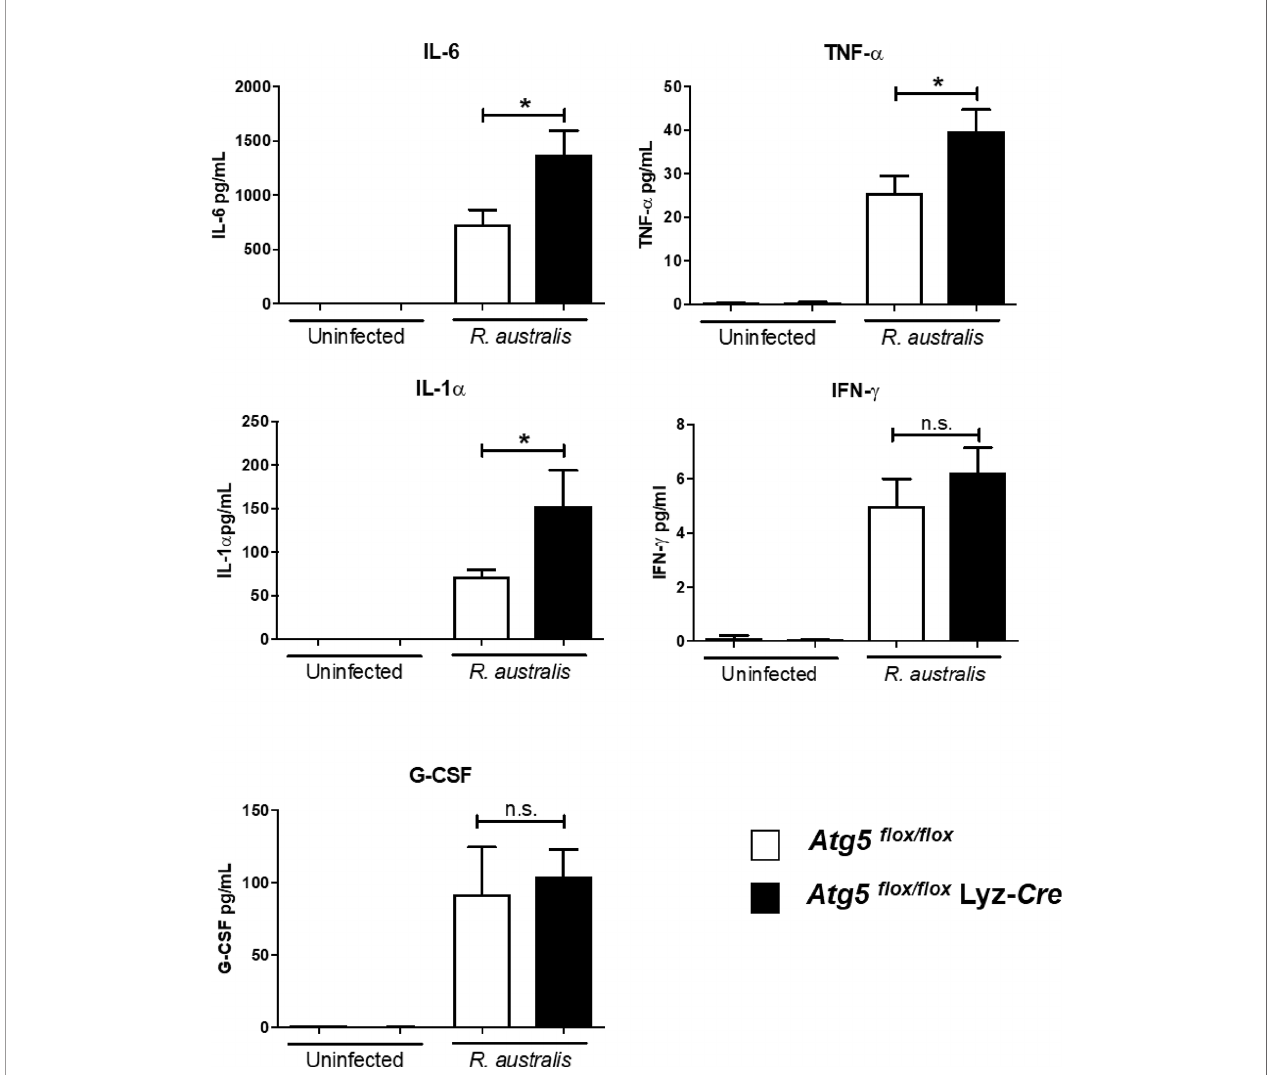
FIGURE 4 | (previous Figure 4). R. australis counteracts the production of pro-in fl ammatory cytokines by infected macrophages via Atg5 -dependent autophagy. BMMs were isolated from Atg5 fl ox/ fl ox Lyz- Cre and Atg5 fl ox/ fl ox mice, and they were infected with R. australis at an MOI of 5. At 24 h p.i., supernatant was harvested. Production levels of cytokines including IL-6, TNF- a , IL-1 a , IFN- g and G-CSF in the supernatant were assessed by Bioplex assay. Results are means ± SE of data from three independent experiments. * p <0.05; n.s., not statistically signi fi